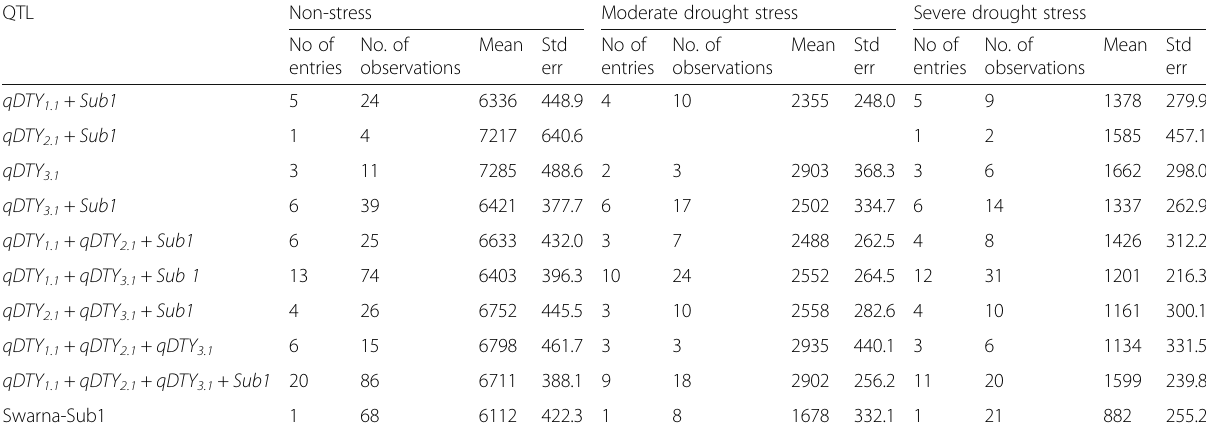
Table 2 The mean grain yield performance of Swarna NILs with different QTL combinations across different locations at three different stress levels